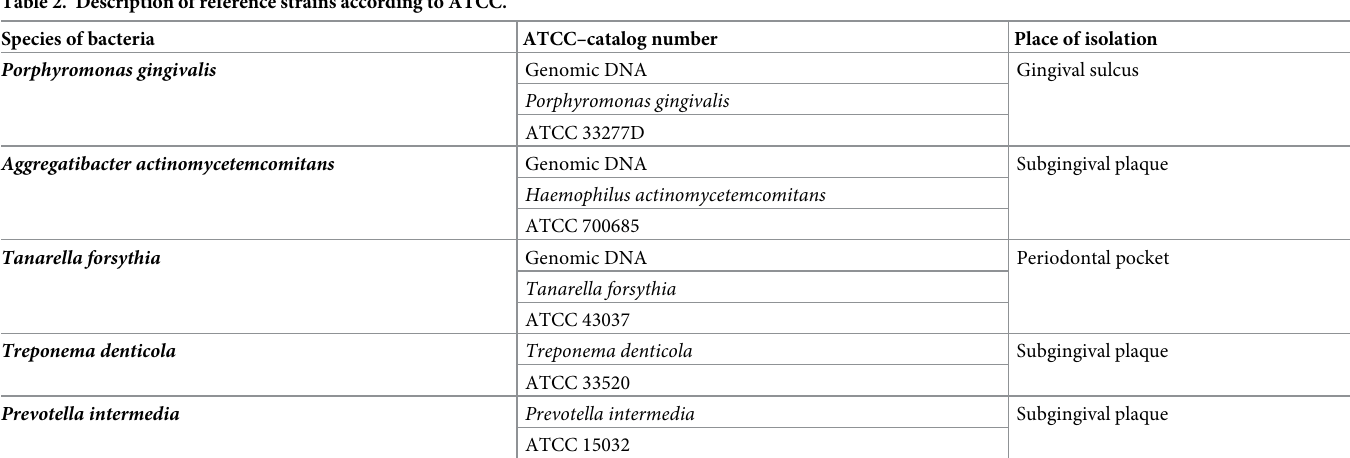
Table 2. Description of reference strains according to ATCC.